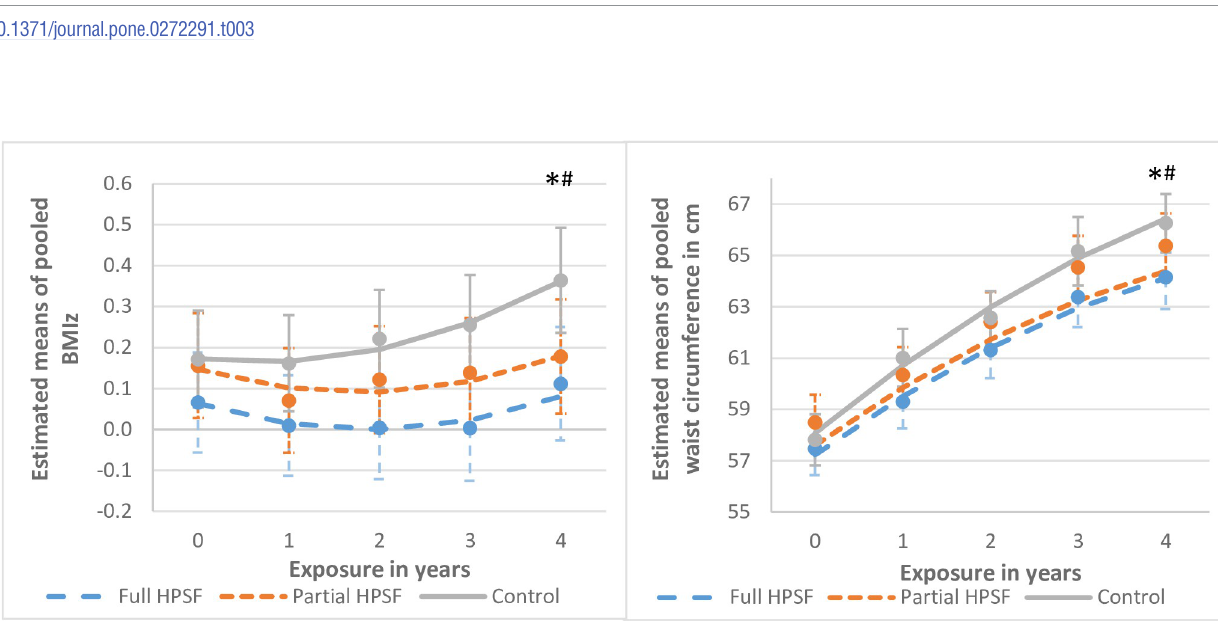
Fig 2. Estimated means and estimated trends of children’s pooled BMIz and waist circumference. Abbreviations: BMIz, body mass index z-score; HPSF, Healthy Primary School of the Future. � = significant difference in trend over time between Full HPSF and control. # = significant difference in trend over time between Partial HPSF and